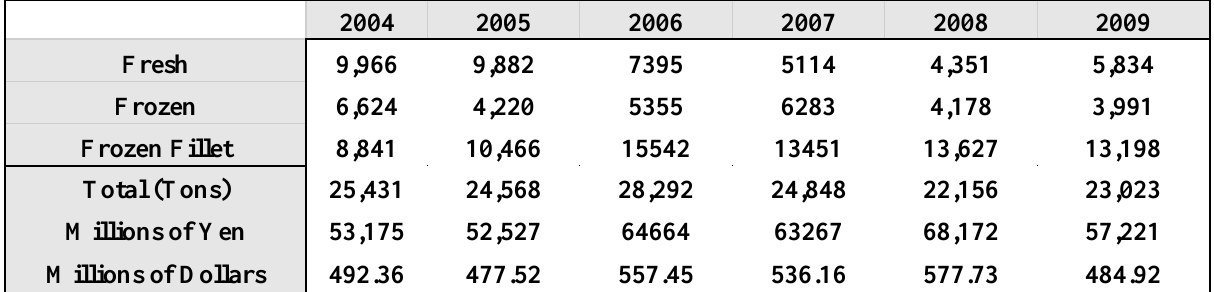
Table 1: Recorded Japanese Imports of ABFT in tons and values 6 (NOAA 2010) 7